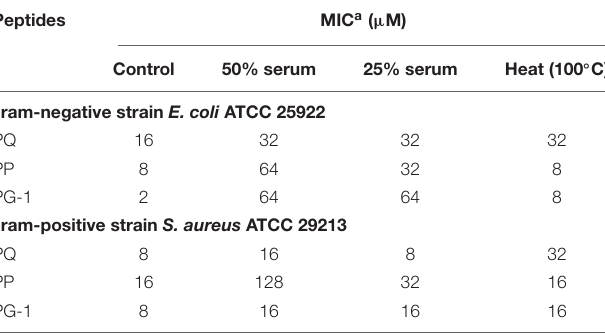
TABLE 5 | Minimum inhibitory concentrations values of peptides in the presence serum and heat. Peptides